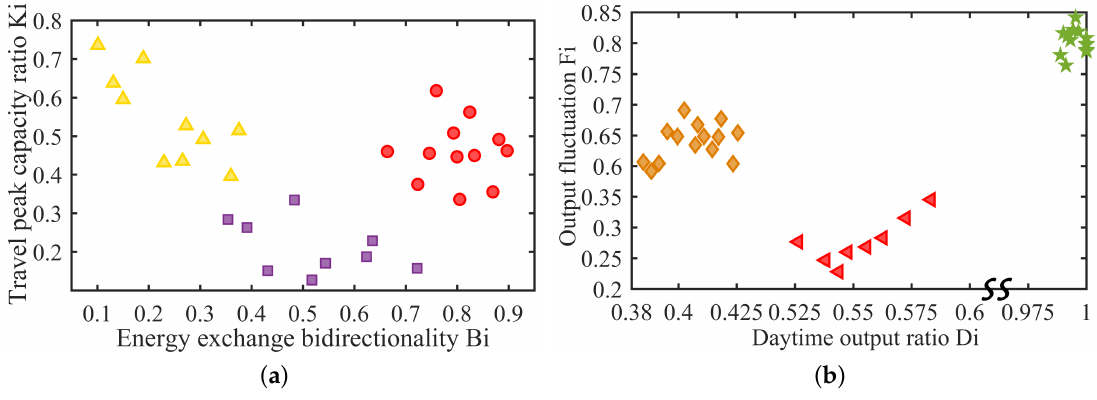
Figure 5. Cluster results of distributed unit output characteristic points. ( a )Cluster results of unidirectional generation group; ( b )Cluster results of bidirectional exchange